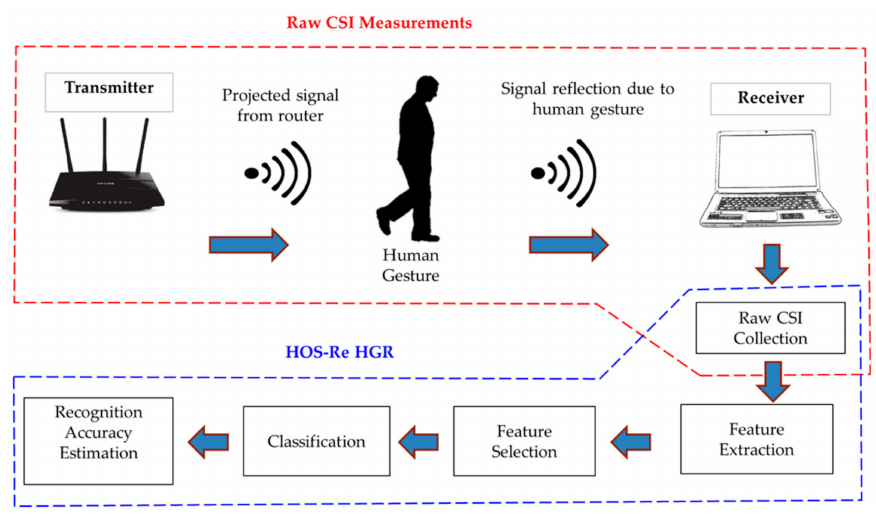
Figure 3. System overview.